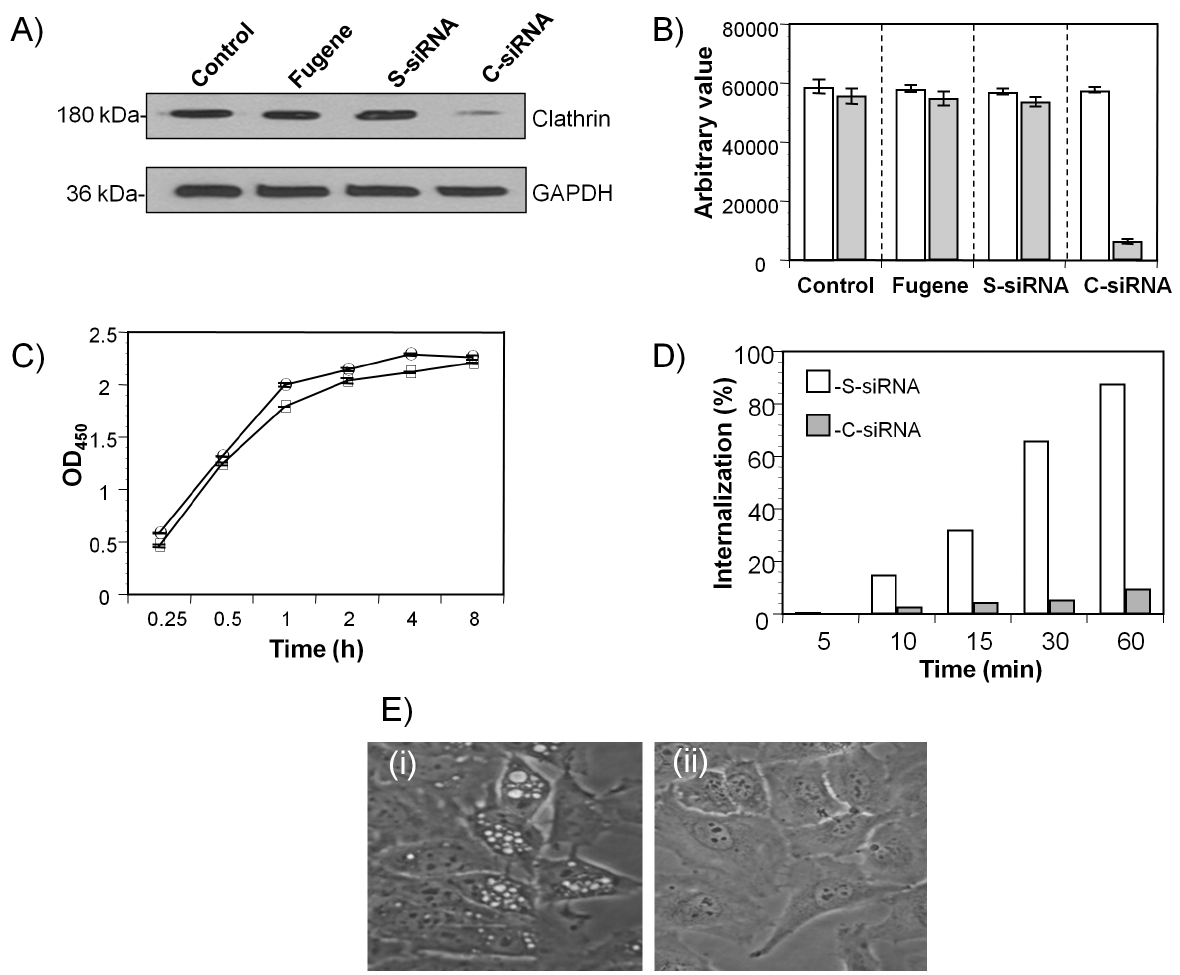
Figure 5. Clathrin-rCARDS toxin association. ( A) Small interfering RNA (siRNA) mediated gene silencing of clathrin heavy chain. HeLa cells were transfected with clathrin heavy chain targeted siRNA (C-siRNA) or scrambled siRNA (S-siRNA) as described in Materials and Methods. Twenty-four h after the second siRNA transfection, cells were lysed and clathrin expression was analyzed using anti-clathrin (1:500) or anti-GAPDH (1:2000) antibodies as detailed in Materials and Methods and described in this legend. (B) Quantification of clathrin heavy chain expression in C-siRNA- and S- siRNA-treated HeLa cells. Clathrin and GAPDH band intensities were estimated using KODAK 1D Image analysis software, and results are from three independent experiments. (C) Binding of rCARDS toxin in clathrin-depleted cells. S-siRNA-treated (open square) and C-siRNA-treated (open circle) HeLa cells were incubated with 10 m g/ml of rCARDS toxin for 1 h at 4 u C, and toxin binding was analyzed as described in Materials and Methods. Data are means 6 SD values from two triplicate experiments. (D) Internalization of rCARDS toxin in clathrin-depleted HeLa cells. S-siRNA-treated (white bar) and C-siRNA-treated (gray bar) HeLa cells were incubated with 10 m g/ml of Biotin-CARDS toxin for 1 h at 4 u C and shifted to 37 u C for 1 h. After removing surface-bound biotin with MESNA, internalized rCARDS toxin was measured as described in Materials and Methods. (E) Clathrin effect on rCARDS toxin-mediated vacuole formation. S-siRNA-treated (i) and C-siRNA-treated (ii) HeLa cells were incubated with 50 m g/ml of rCARDS toxin for 24 h at 37 u C and analyzed under light microscopy for vacuole formation as described previously